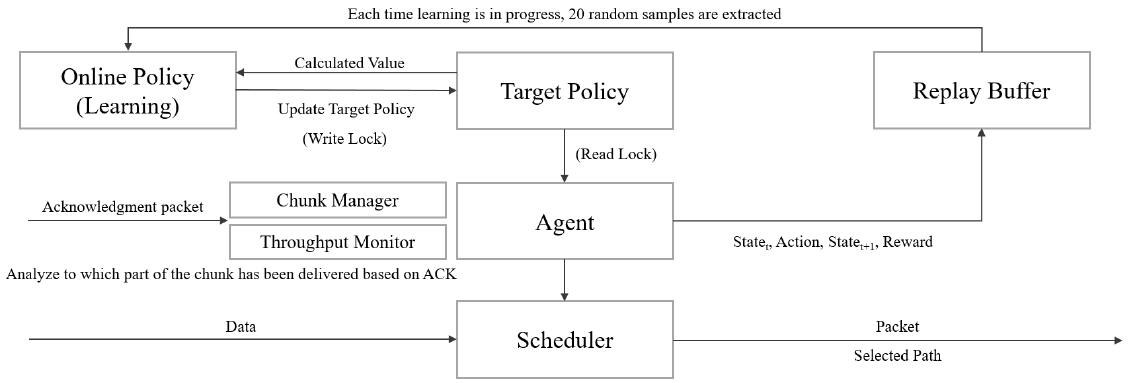
Figure 4. Overall system